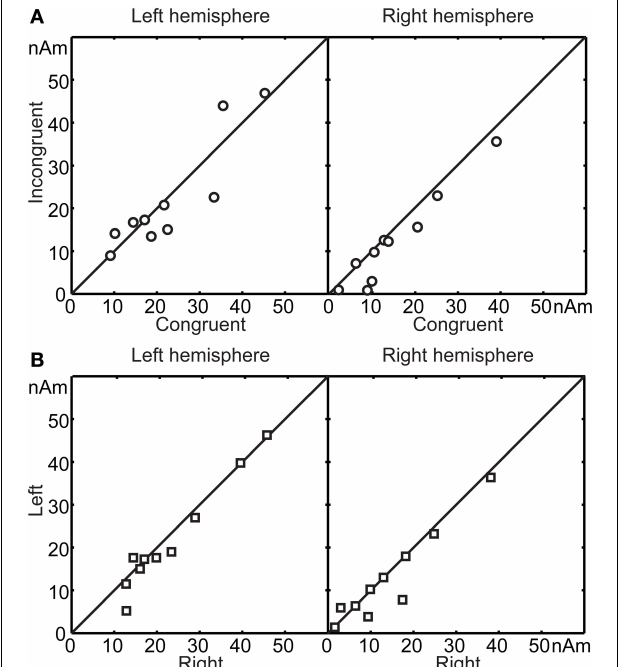
FIGURE 5 | Amplitude spectra of noise; means of 204 gradiometers. Solid lines represent measurements without subject, and dashed line measurement with subject. Black, no eye tracker; blue, green and red lines, eye tracker at 100, 117 and 140 cm distance from the measurement helmet. Insert focuses on the frequency range of 0–40